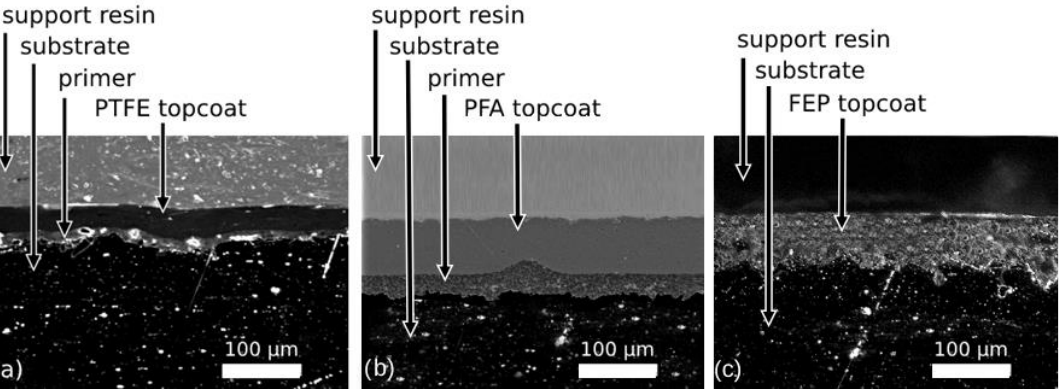
Figure 1. Sectional view of the coating: ( a ) TF-851 E PTFE, ( b ) TF-76521 PFA, and ( c ) TF-3531 FEP. The aspect of the coatings object of study is shown in Figure 2, in the images of the supply state taken by a confocal microscope.